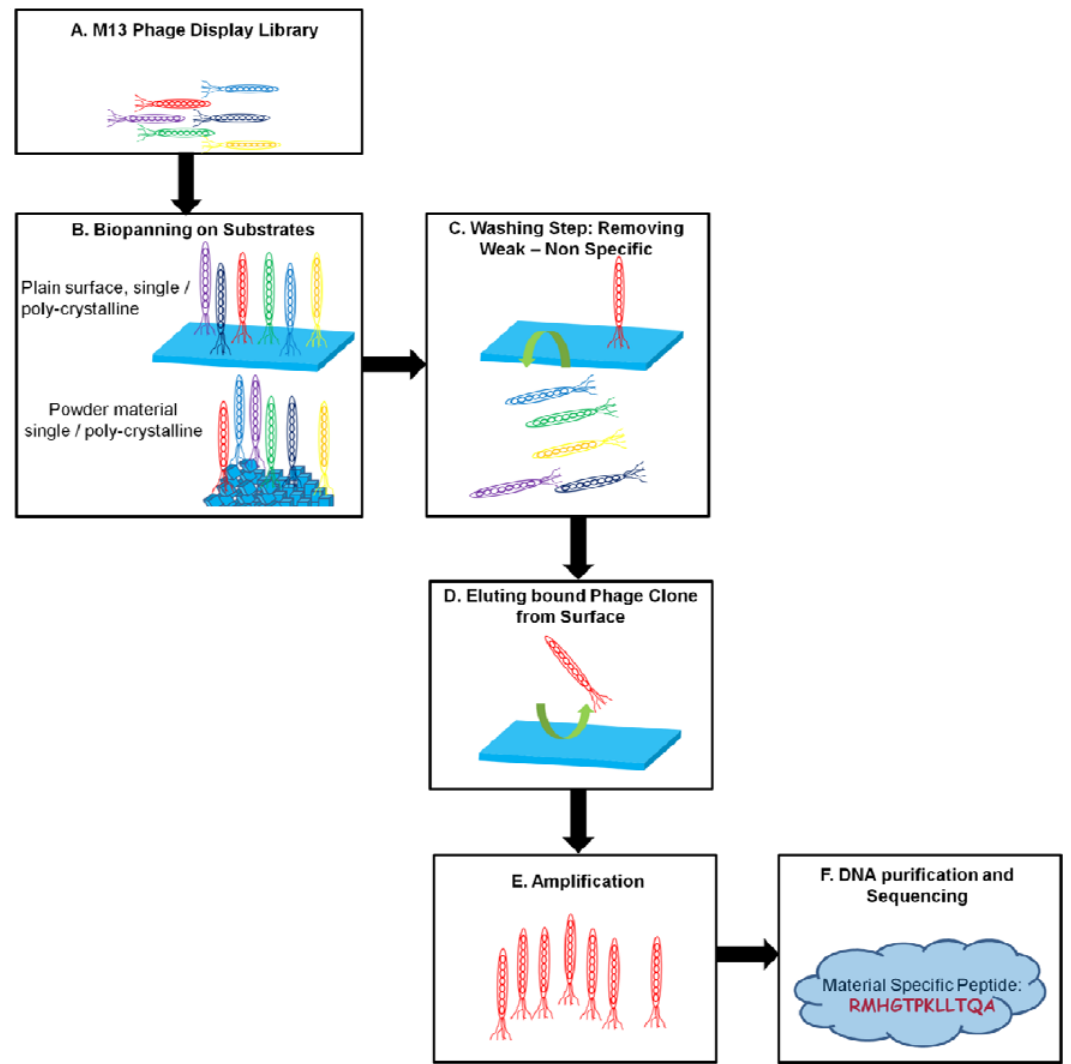
Figure 3. Schematic representation of PD selection of inorganic binding